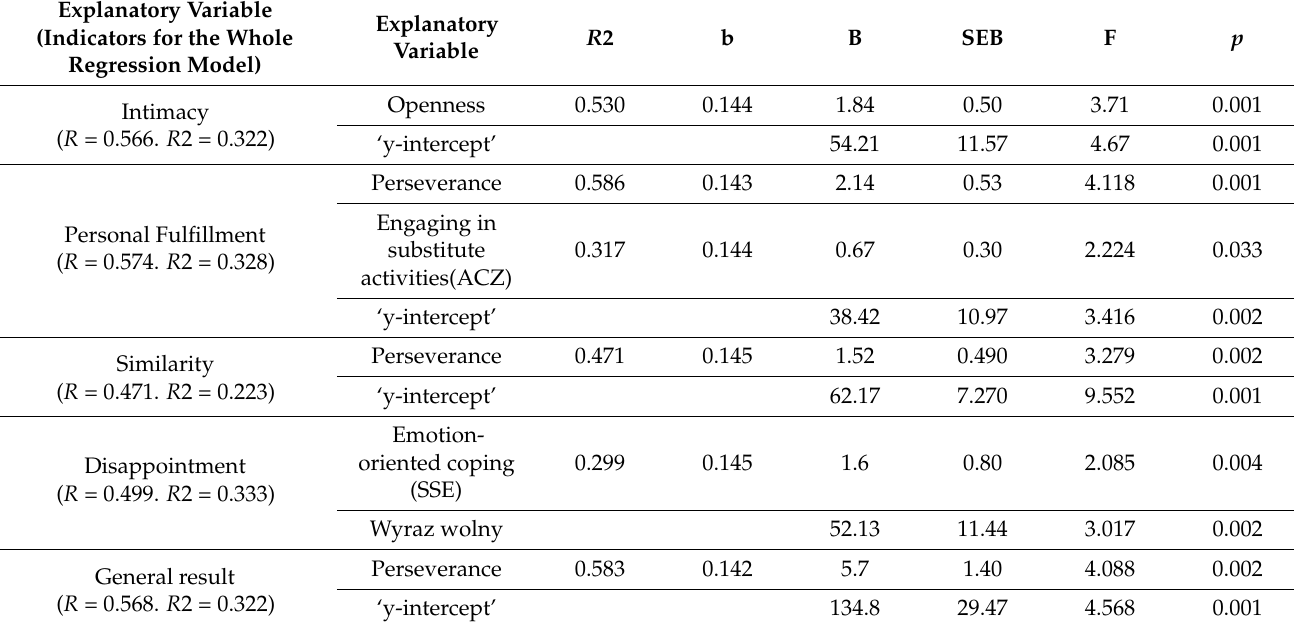
Table 4. Predictors (resilience, stress coping styles) of marital satisfaction among the studied